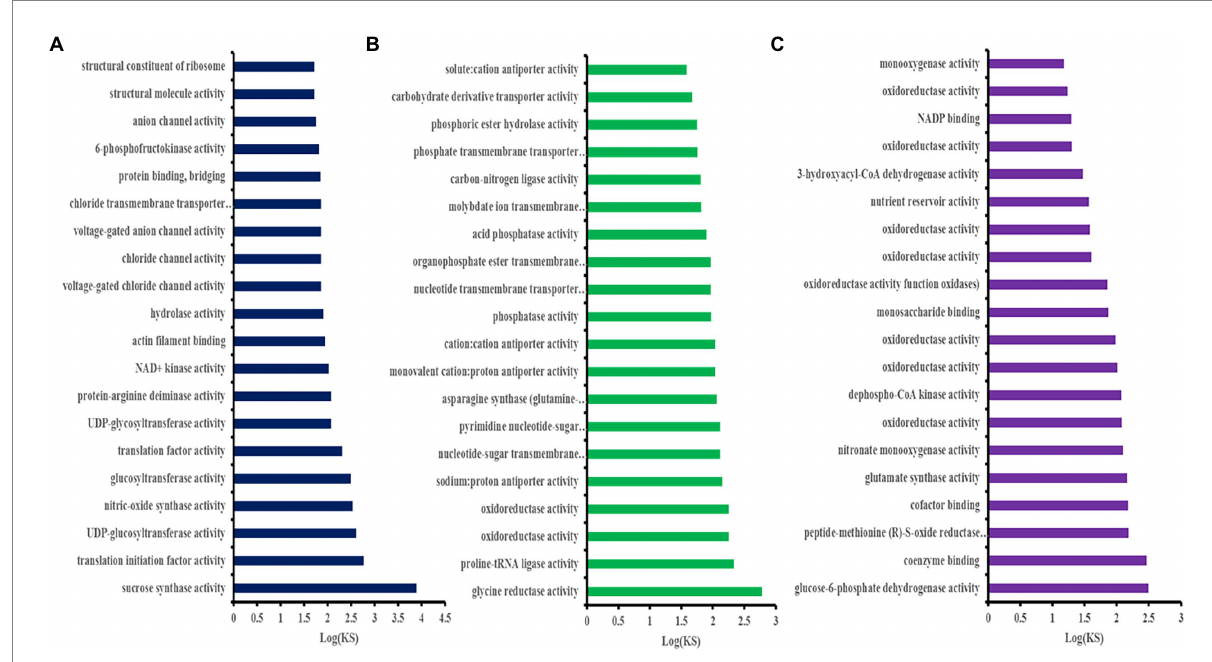
FIGURE 4 Gene ontology (GO) enrichment analysis of the Helictotrichon virescens hub genes (MF of the top 20 clusters) from the brown (A) , blue (B) , and turquoise (C) modules.